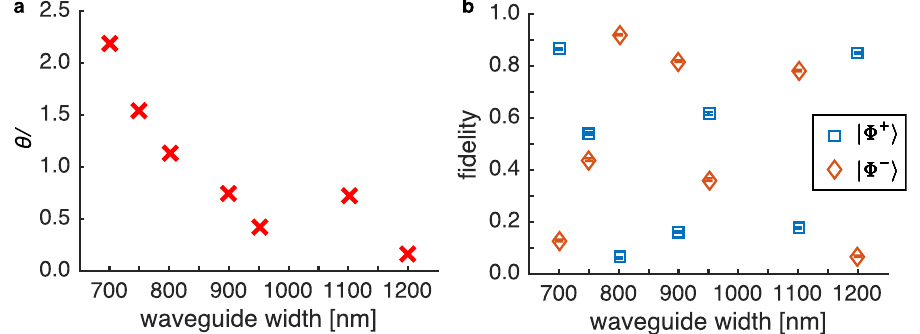
Figure 7. ( a ) Relative phases of the | VV 〉 with respect to the | HH 〉 of the generated entangled state from different waveguides. ( b ) Fidelity of the generated states from several waveguides to the Bell states |Ф ± 〉 = | HH 〉 ± | VV 〉 , displaying a possibility of directly and tunably generating Bell states with the proposed scheme and without any post-generation compensation